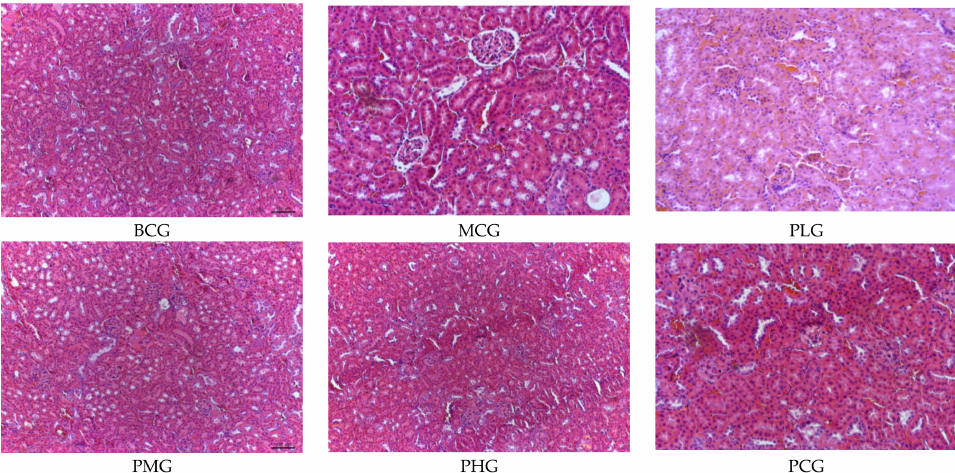
Figure 1. Effect of P. perfoliatum extract on liver HE staining induced by alcohol in mice (40 × ). Compared with the model group, the symptoms of liver cells in P. perfoliatum extract groups were improved, and the liver cord structure in the low dose group was clear, the cells were slightly swollen, and there was no obvious fatty degeneration in the tissue.